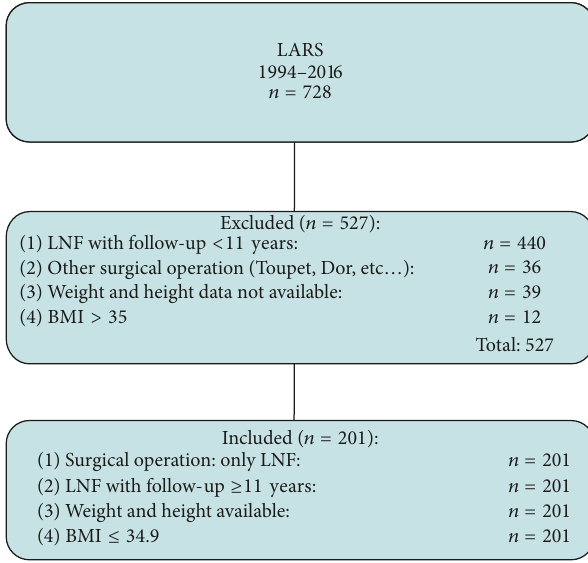
Figure 1: Inclusion and exclusion